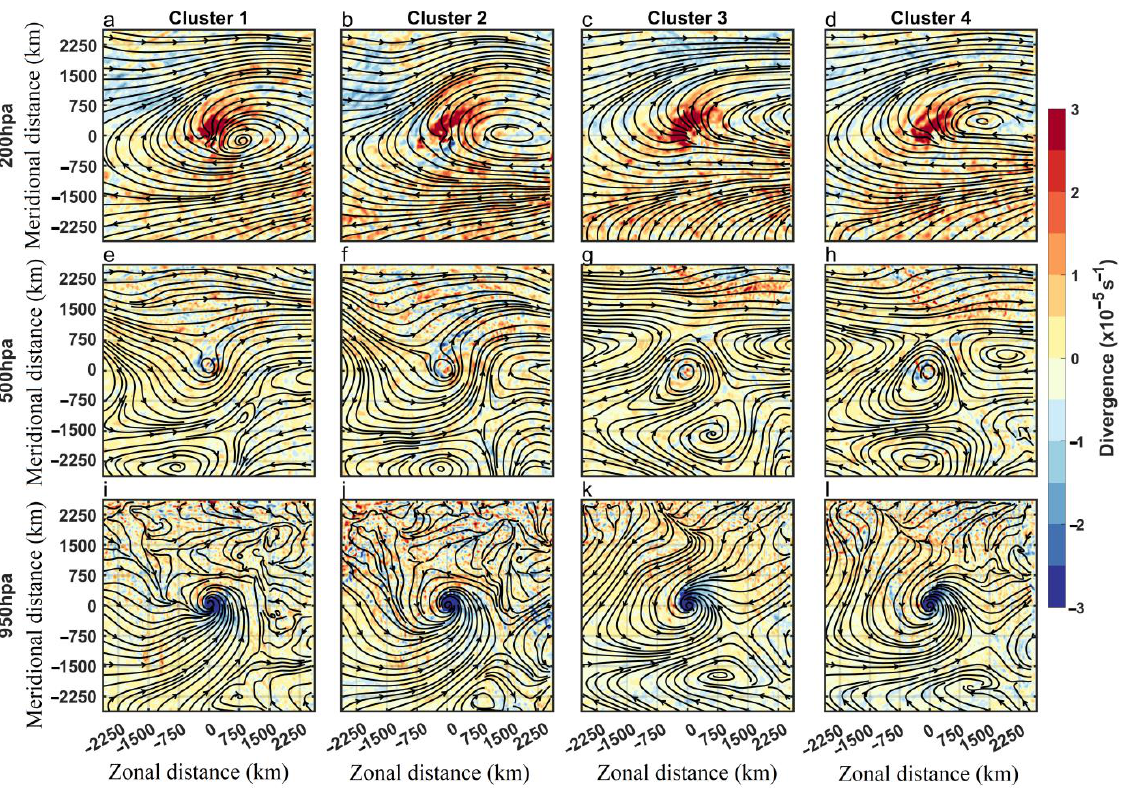
Figure 3. The mean composites of divergence (shaded, × 10 − 5 s − 1 ) and wind fields (streamlines) obtained from ERA5 data for each cluster at different levels 200 hPa ( a – d ), 500 hPa ( e – h ), and 950 hPa ( i – l ).